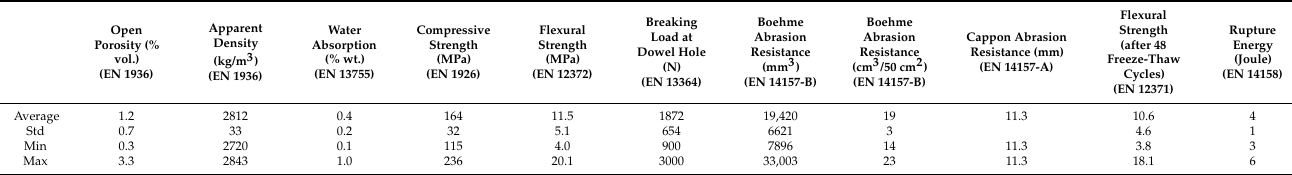
Table 2. Average values of physical mechanical properties determined for dolomitic marbles. Open Porosity(%